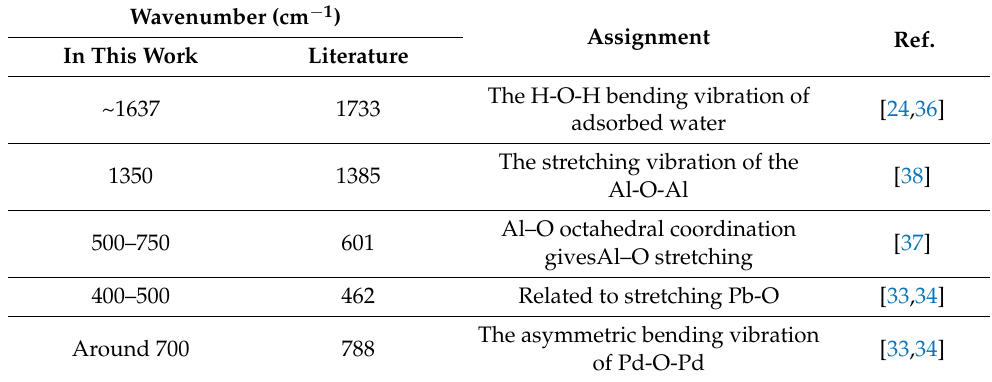
Table 1. FTIR band assignments of PdO- x %Al 2 O 3 composites.